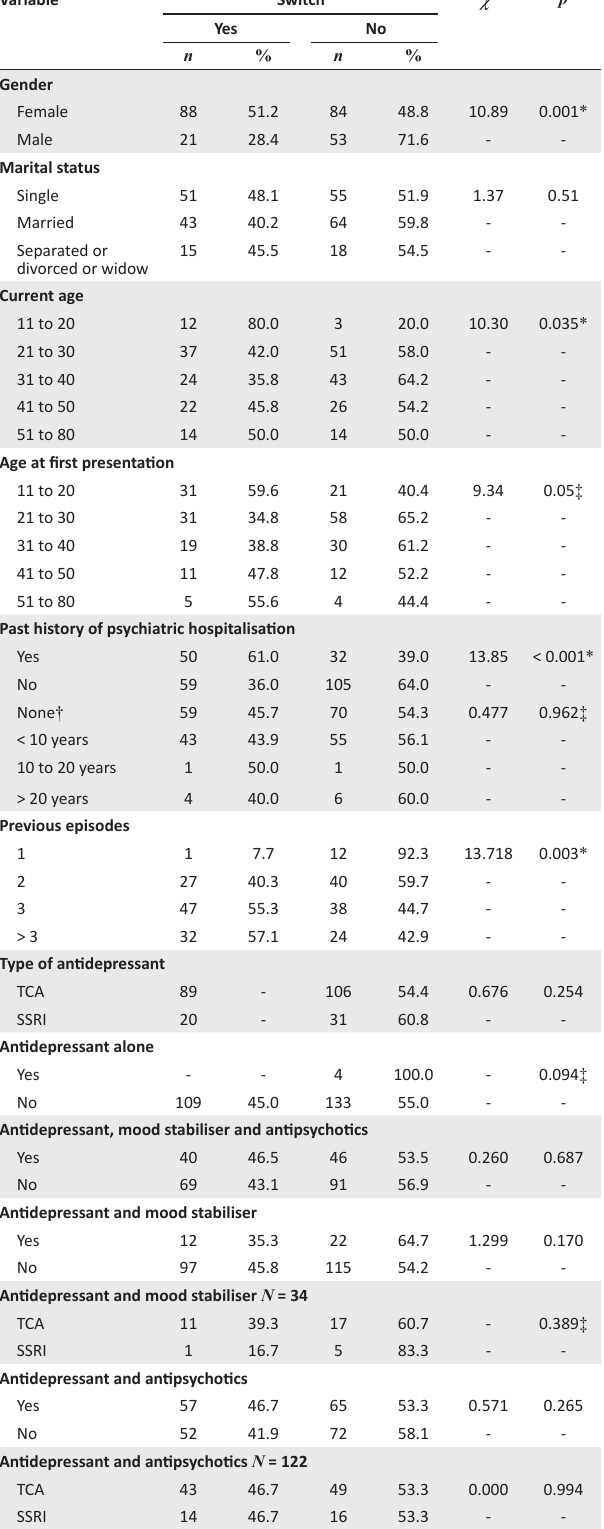
TABLE 2: Socio-demographic and clinical variables with the presence of switch.